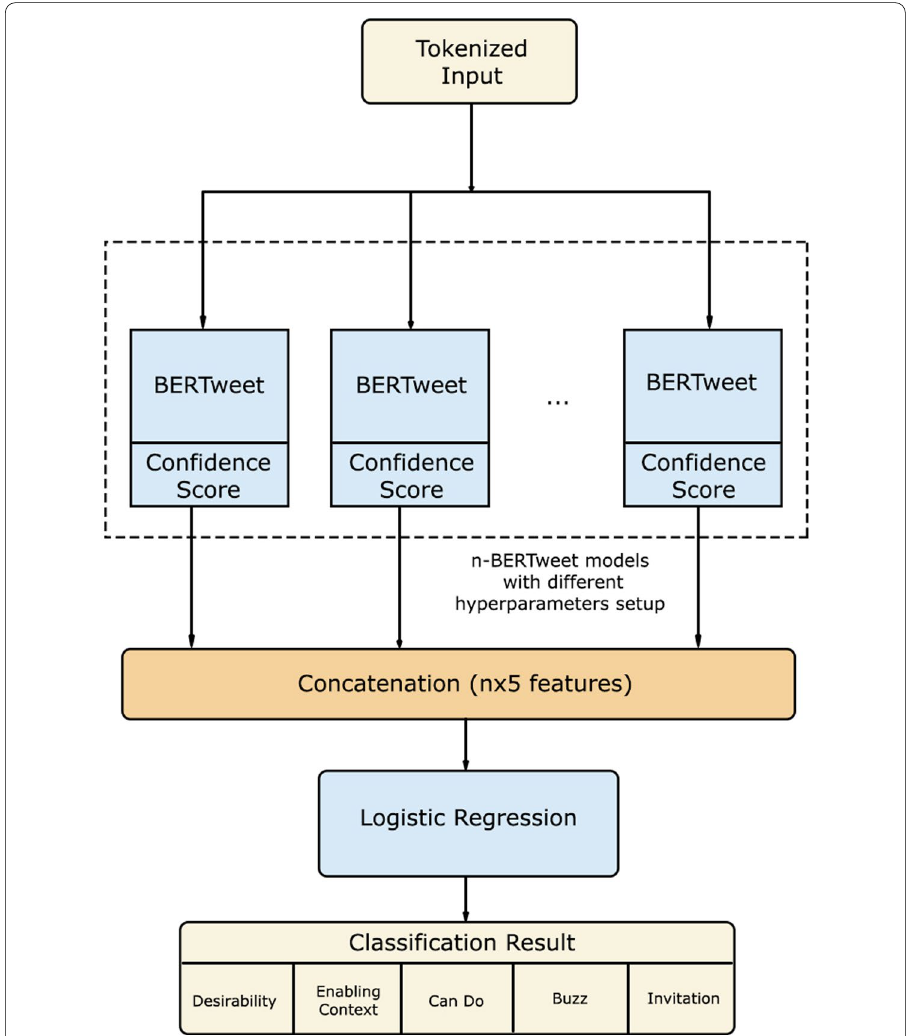
Fig. 7 BERTweet Stacking Ensemble